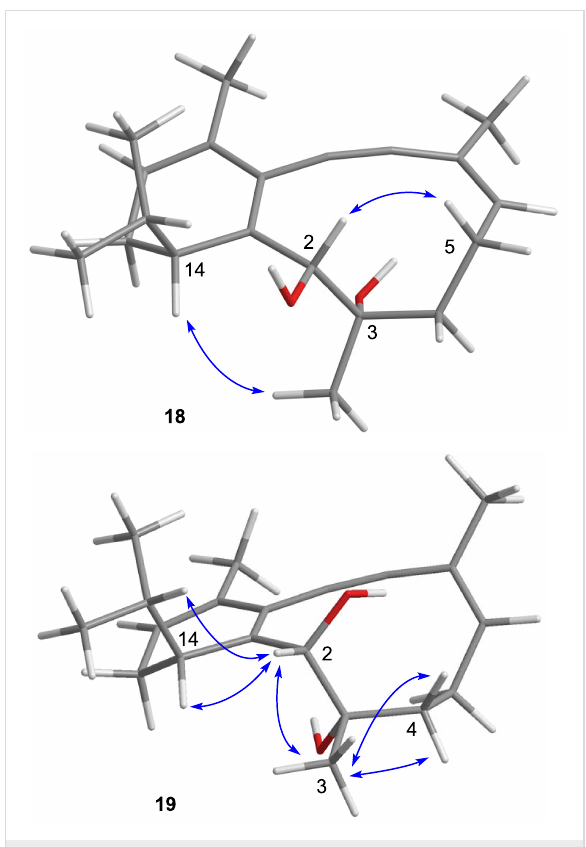
Figure 3: Preferred conformations of diastereomeric diols 18 and 19 including decisive NOESY correlations.